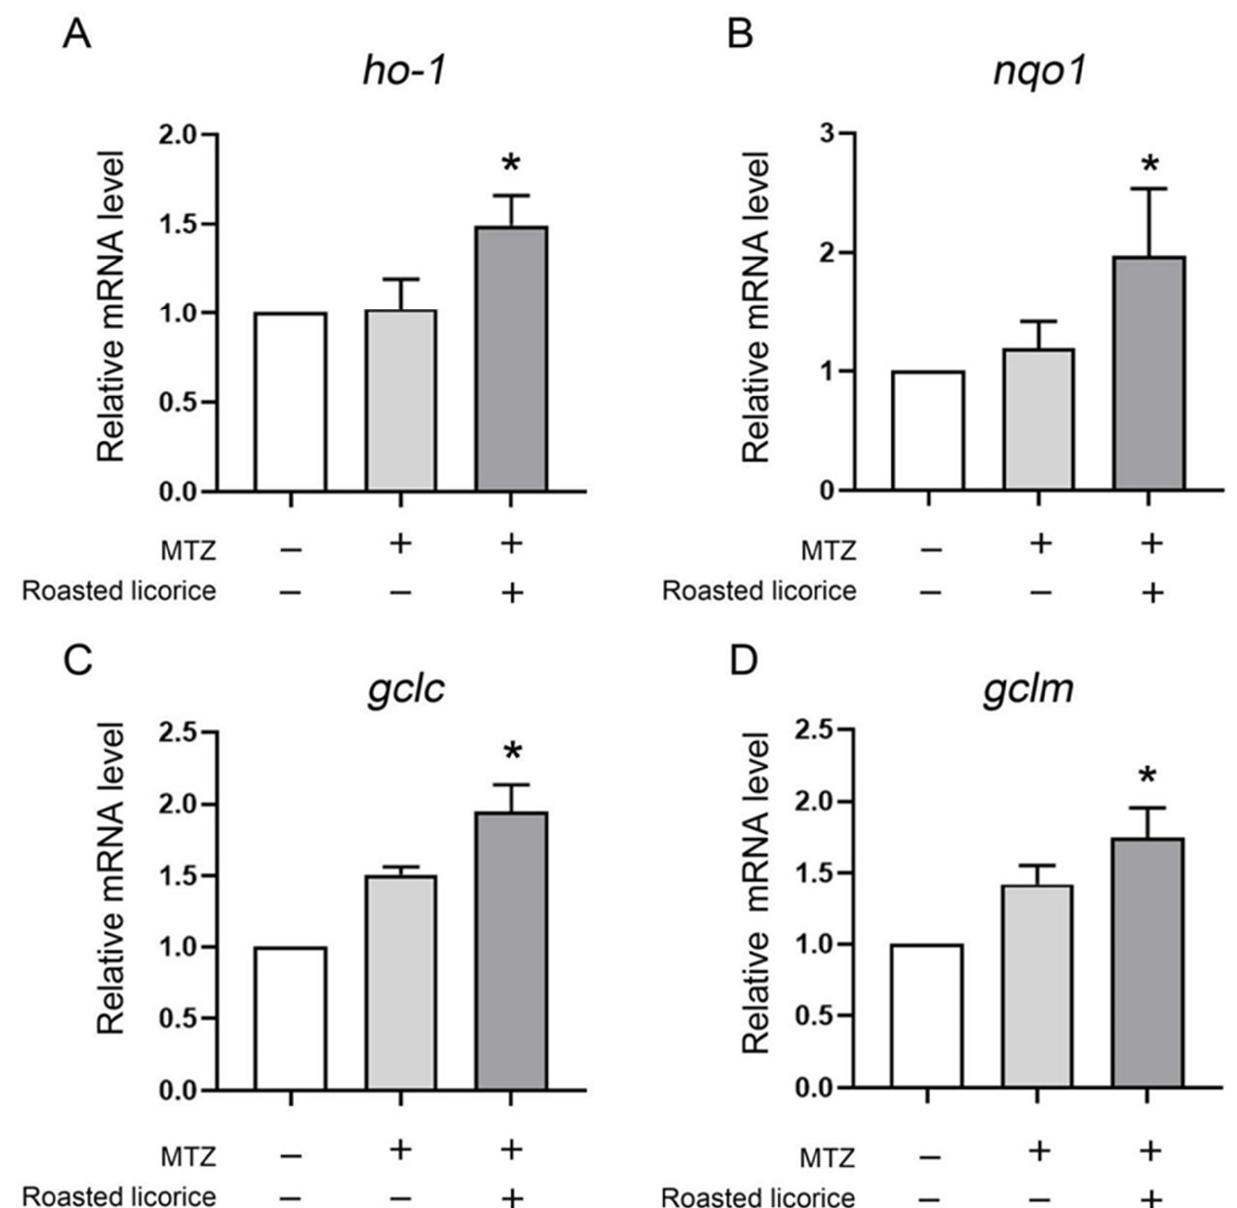
Figure 2. Transcriptional alteration of antioxidant genes in transgenic zebrafish Tg (Krt4-NTR:GFP) cy17: ( A ) ho-1 ; ( B ) nqo1 ; ( C ) gclc ; ( D ) gclm . * Significant difference as compared with the MTZ treat- ment group, p < 0.05.